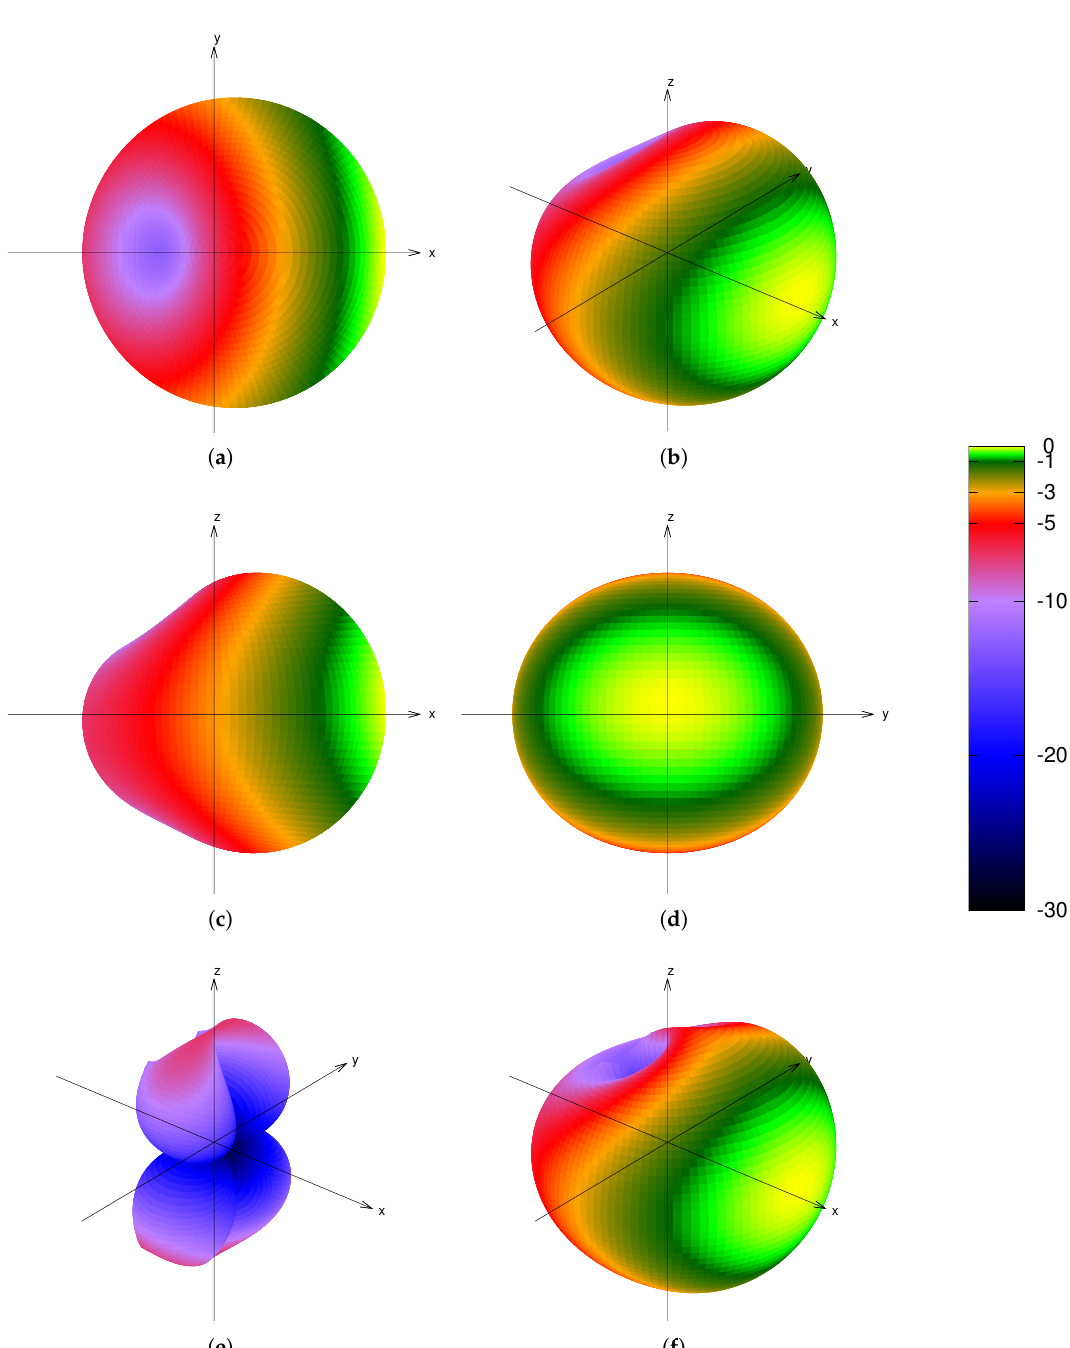
Figure 4. Free-space, far-field 3-dimensional simulated pattern (dB) for the Vertical Half Rhombic Prototype. The antenna is oriented in the xz-plane so that the general direction of maximum radiation is towards the positive “x” direction. ( a ) shows the plan view while ( c , d ) show the side and front elevations of the pattern. The remaining oblique views, ( b , e , f ) show the radiation patterns for the combined, horizontal and vertical polarisations respectively. The images show relative directional antenna gain and are mapped with the ( − 30 dB,0 dB ) (cid:55)→ r = ( 0,1 ) radius of the unit sphere. Gain is normalized such that 0 dB (cid:55)→ − 21.15